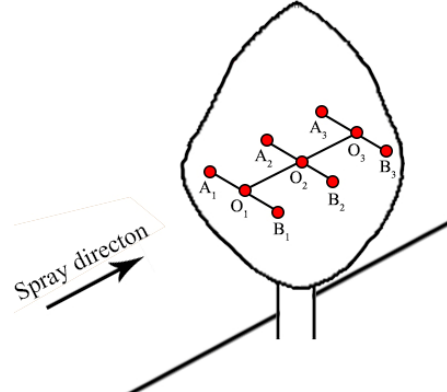
( b ) Schematic diagram of measurement points